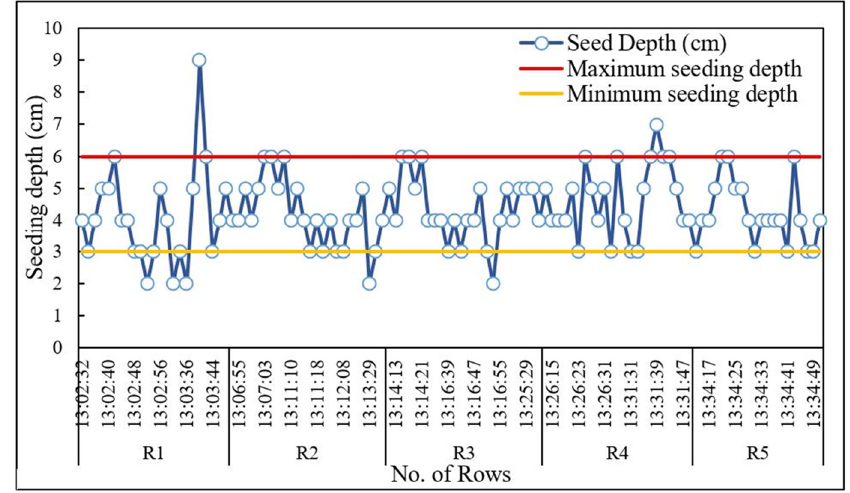
Figure 2. Seeding depth range with SDCS during wheat sowing 2021.